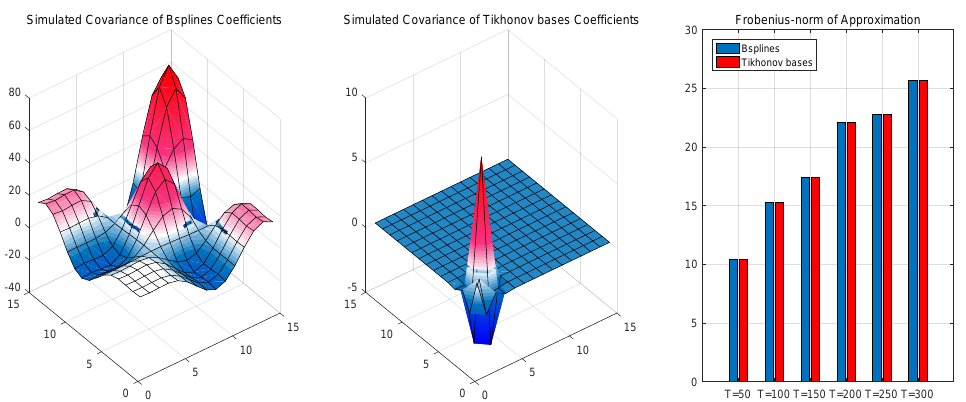
Figure 4. Investigation of the covariance surface